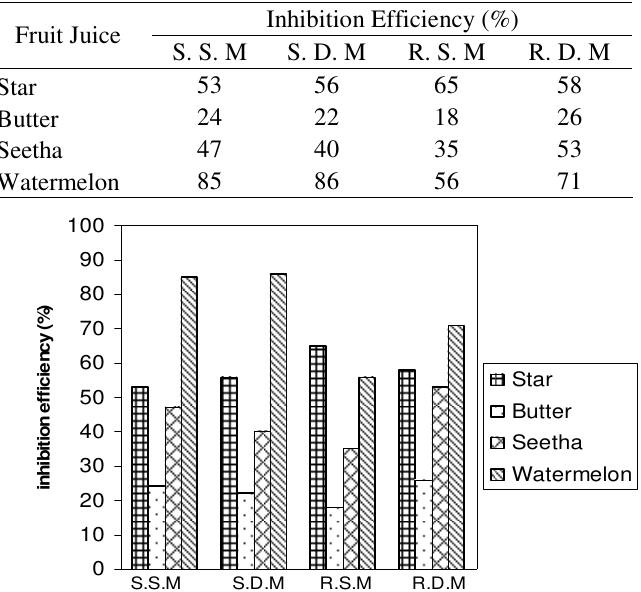
Figure 1. Inhibition of calcium oxalate mineralization by fruit